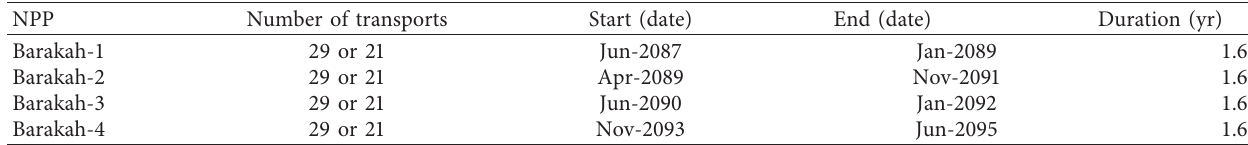
Table 4: Estimated transport periods based on 7-year condition for four types of casks.